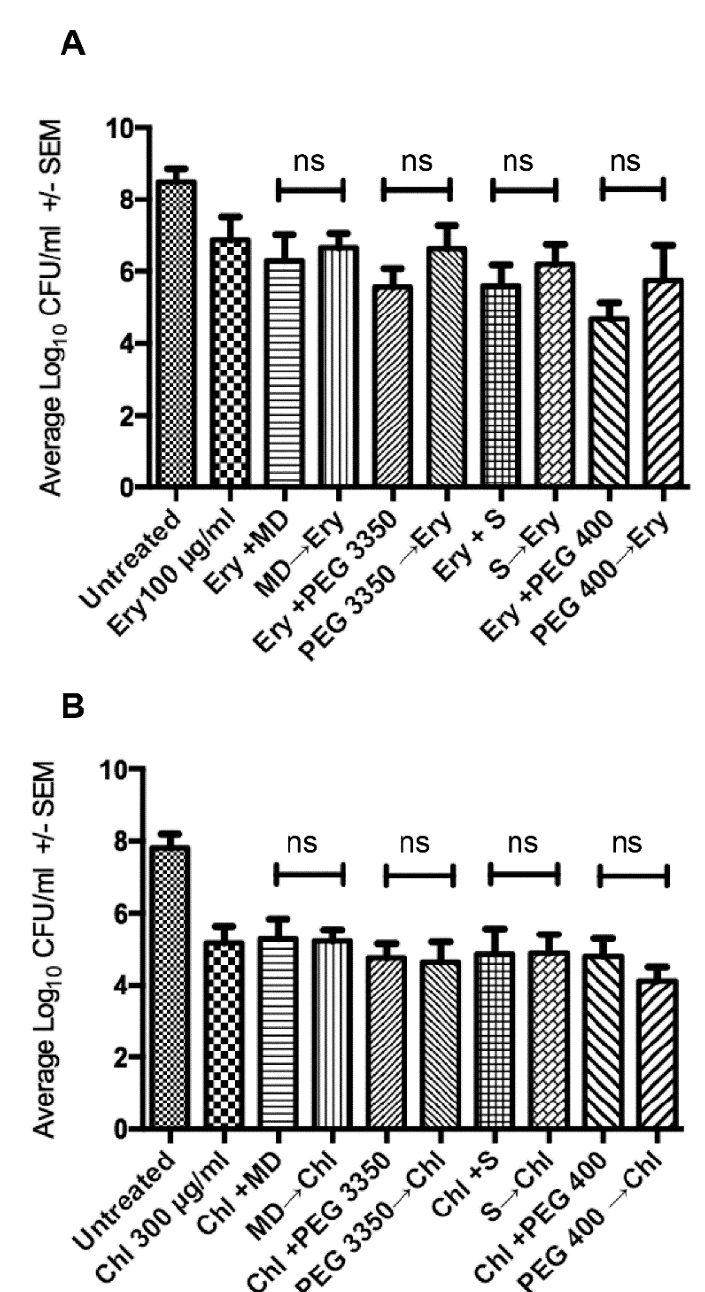
Figure 2. Acinetobacter baumannii pre-formed biofilms exposed to antibiotic alone, combined ( + ) or sequential ( → ) treatment with osmotic compounds maltodextrin (MD), sucrose (S), polyethylene glycol (PEG 3350 or PEG 400) followed by ( A ) erythromycin (Ery,100 µ g / mL) or ( B ) chloramphenicol (Chl 300 µ g / mL). Error bars represent the standard error of the means calculated from three biological